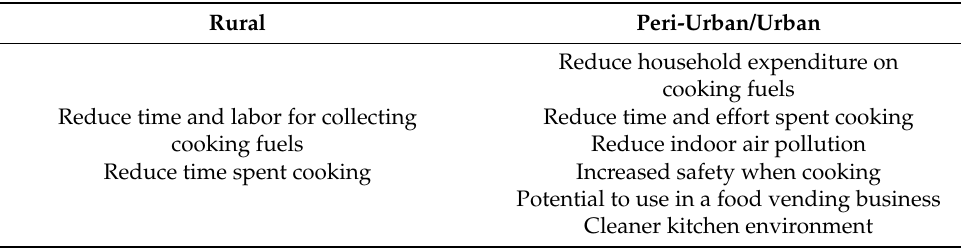
Table 4. Drivers and value proposition factors for rural and peri-urban/urban end-user groups to adopt EPCs. Rural Peri-Urban/Urban Reduce household expenditure on cooking fuels Reduce time and labor for collecting Reduce time and effort spent cooking cooking fuels Reduce indoor air pollution Reduce time spent cooking Increased safety when cooking Cleaner kitchen